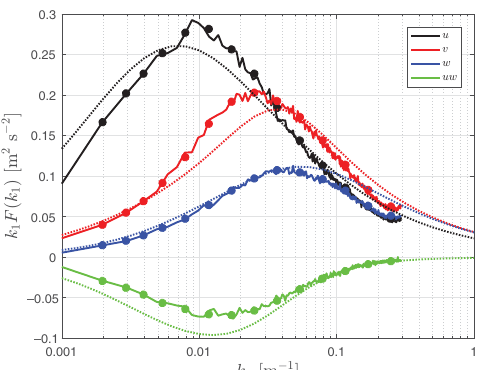
15 Figure 9. Power spectrum for different velocity components. The Figure 9. Power spectrum for different velocity components. The solid lines show the ensemble-average spectra of all 10-min sonic- solid lines show the ensemble-average spectra of all 10min sonic- anemometer spectra, the markers the k -based logarithmically-average spectra of all 10-min spectra, and the dotted lines a fit to the spectra anemometer spectra; the markers, the k based logarithmically- using the Mann model average spectra of all 10min spectra; and the dotted lines, a fit to the spectra using the Mann frequencies is due to noise. Figure 10-right shows the effect of a noise filter, which is based on the method by Kirchner (2005), on the ensemble-average Avent radial velocity spectra.